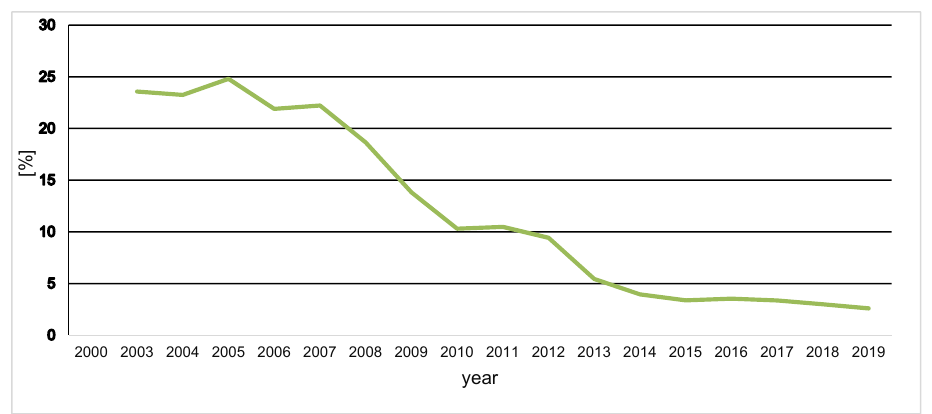
Table 2. Land restoration and landfill cover use of compost (%) in major compost producing EU countries [15].